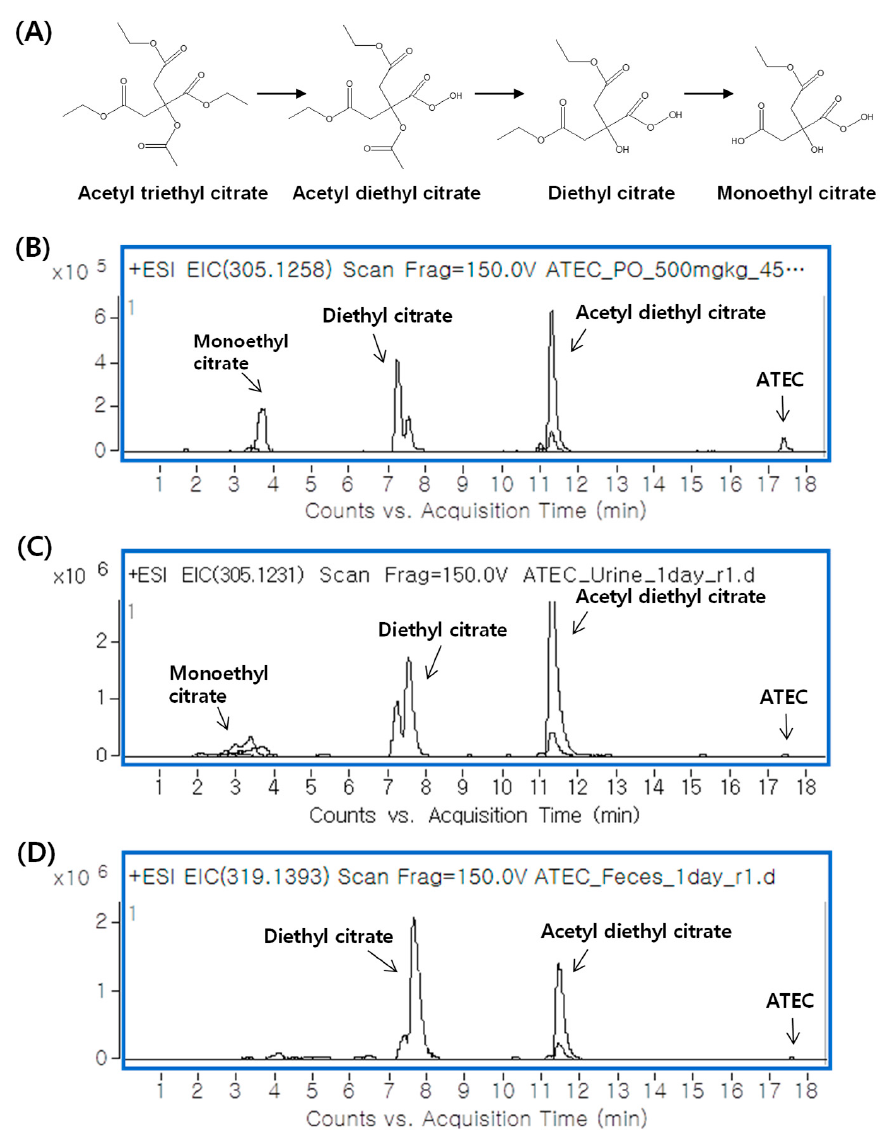
Figure 5. ( A ) Proposed metabolic pathway of ATEC and representative LC–MS chromatograms of ( B ) plasma, ( C ) urine, and ( D ) feces from rats that were orally administered ATEC. Table 4. Accurate mass data for ATEC and its metabolites.